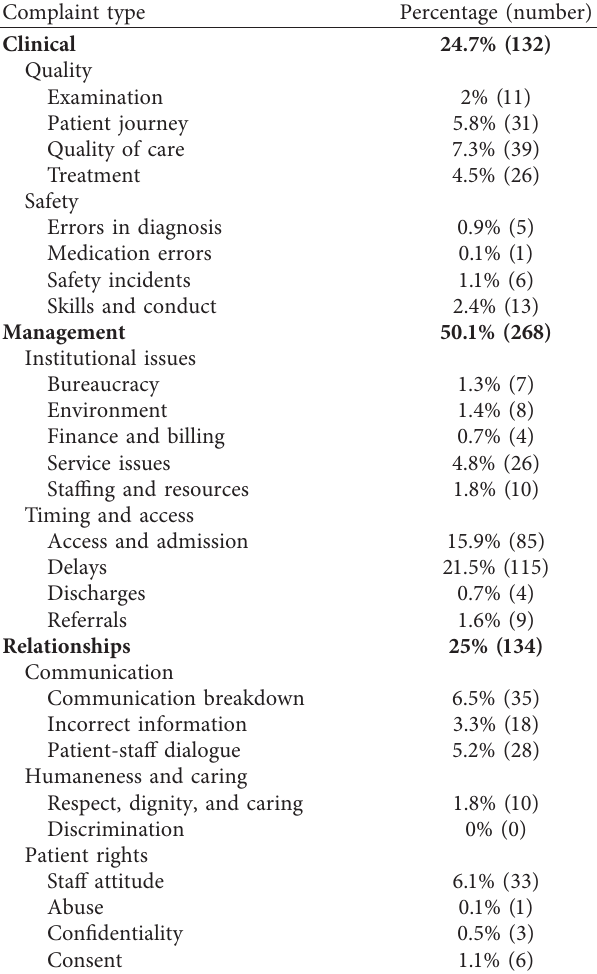
Table 1: Summary of complaints categories as per the coding